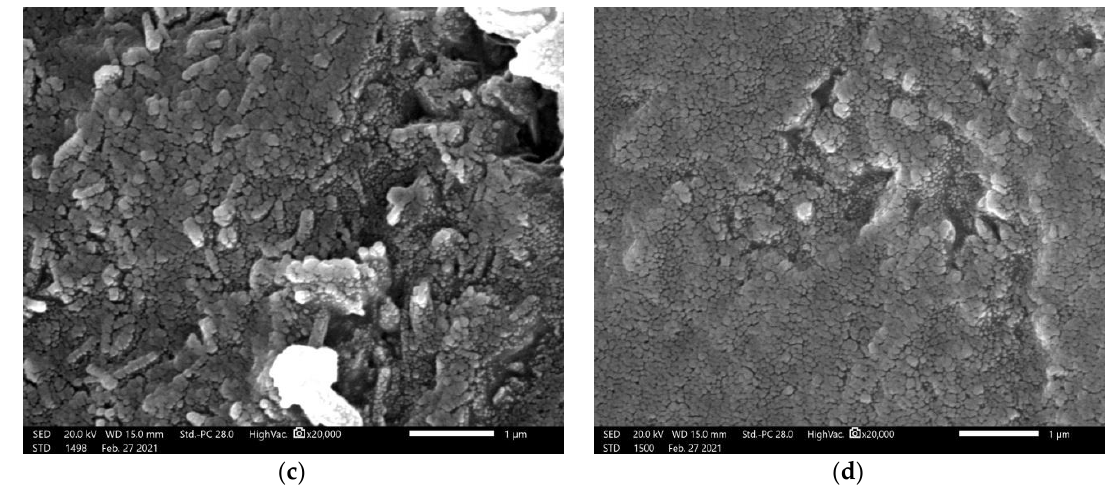
Figure 1. The scanning microscope images of ( a ) blank concrete sample, ( b ) concrete sample with bulk 5% of bismuth oxide sample, ( c ) concrete sample with 5% of nano-bismuth oxide sample, and ( d ) concrete sample with 10% of nano-bismuth oxide sample. Table 2. Elemental composition and densities of concrete samples.